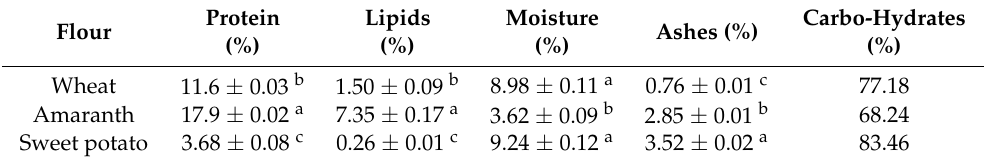
Table 2. Proximate composition of the wheat, amaranth and sweet potato